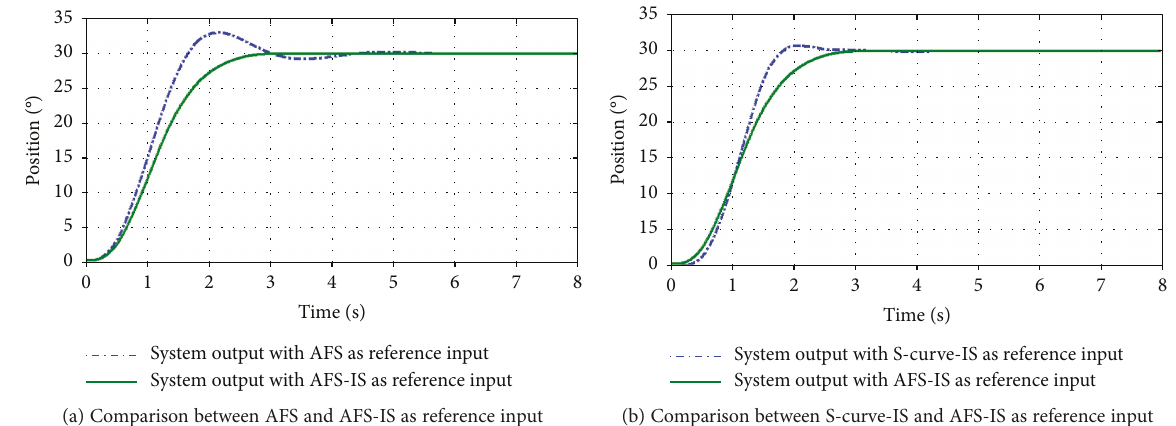
Figure 8: Input shaper combined with S-curve and AFS-curve as the motion pro fi le.